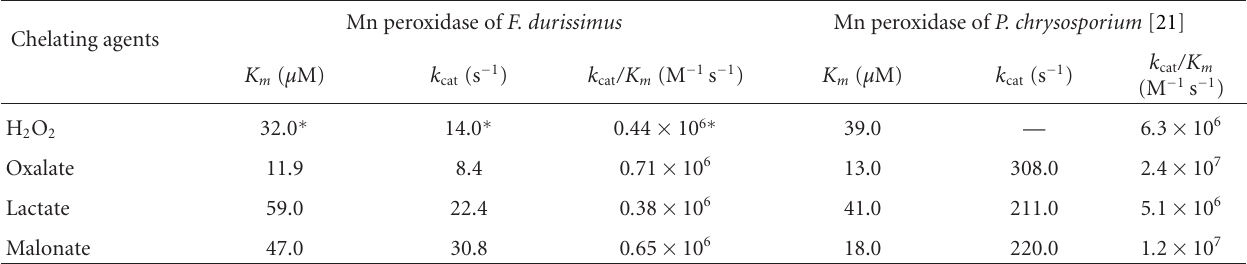
Table 2: K m , k cat , and k cat /K m values for the purified Mn peroxidase in presence of di ff erent chelating agents.